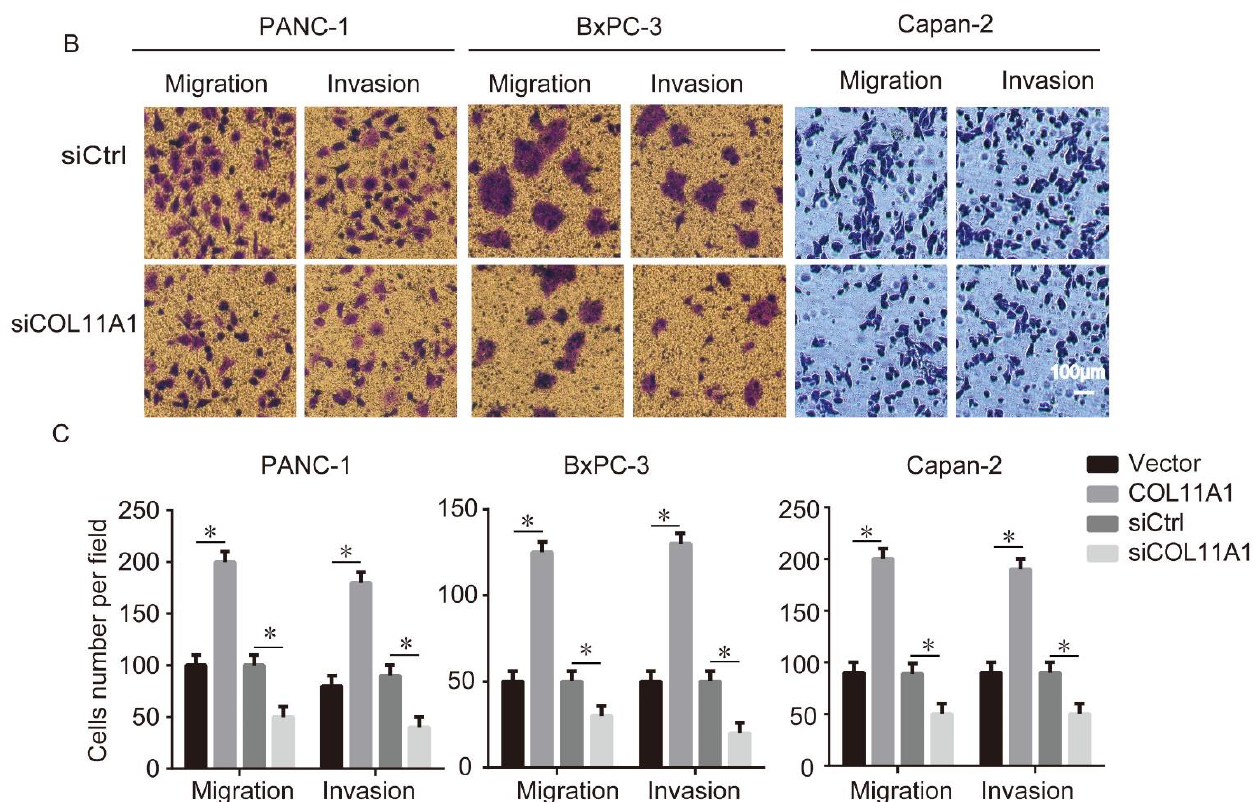
Figure 1. Collagen type XI α1 (COL11A1) promoted the migration and invasion abilities of pancreatic cancer cells: ( A ) overexpression of COL11A1 induced by pCMV3-COL11A1 promoted the migration and invasion of Capan-2, BxPC-3, and PANC-1 cells; ( B ) small interfering (si)-COL11A1 inhibited the migration and invasion of PANC-1, BxPC-3, and Capan-2 cells; ( C ) the number of invasive and migrated pancreatic cancer cells treated with pCMV3-COL11A1 or siCOL11A1 ( n = 3, * p < 0.05).